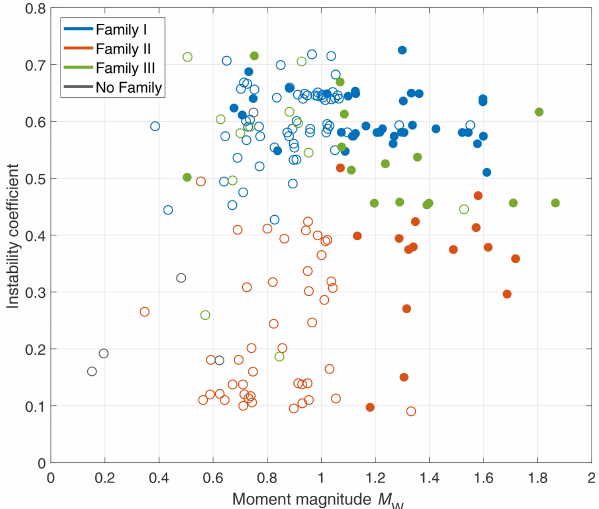
Figure 11. Highest fault instability coefficient of any of the two FPSs for each FM event plotted with moment magnitude. Events with manually picked and estimated polarities are plotted as filled and unfilled circles,